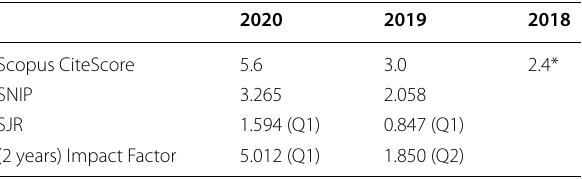
Table 1 Summary of the journal’s performance measured by indexing services